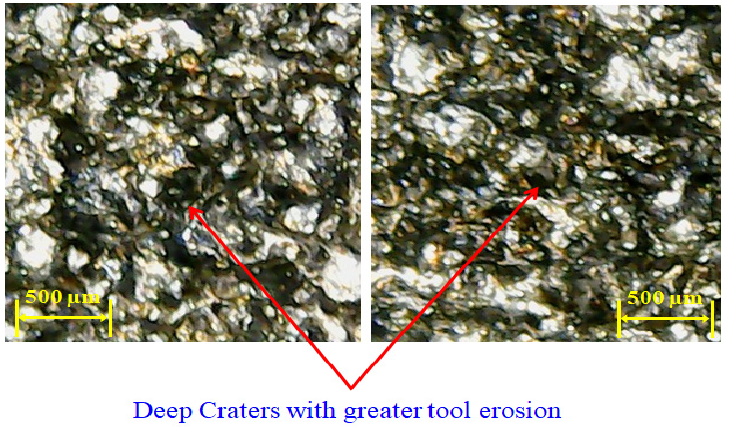
Figure 17. Optical micrographs showing deep craters with high tool wear rate at 8 µsec.